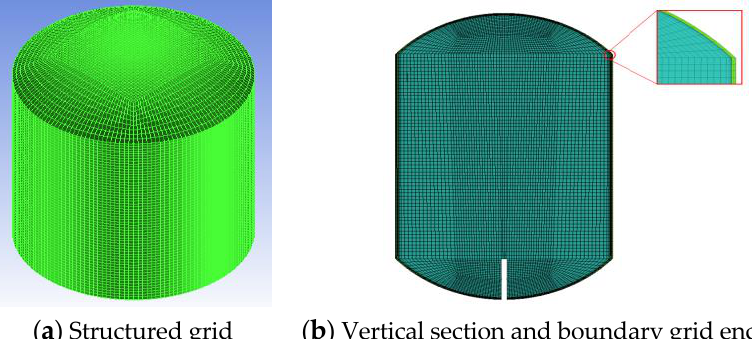
Figure 3. 3D model structured grid. ( a ) Structured grid of 3D calculated model of the liquid hydrogen storage tank; ( b ) Vertical section and boundary grid encryption of 3D model.